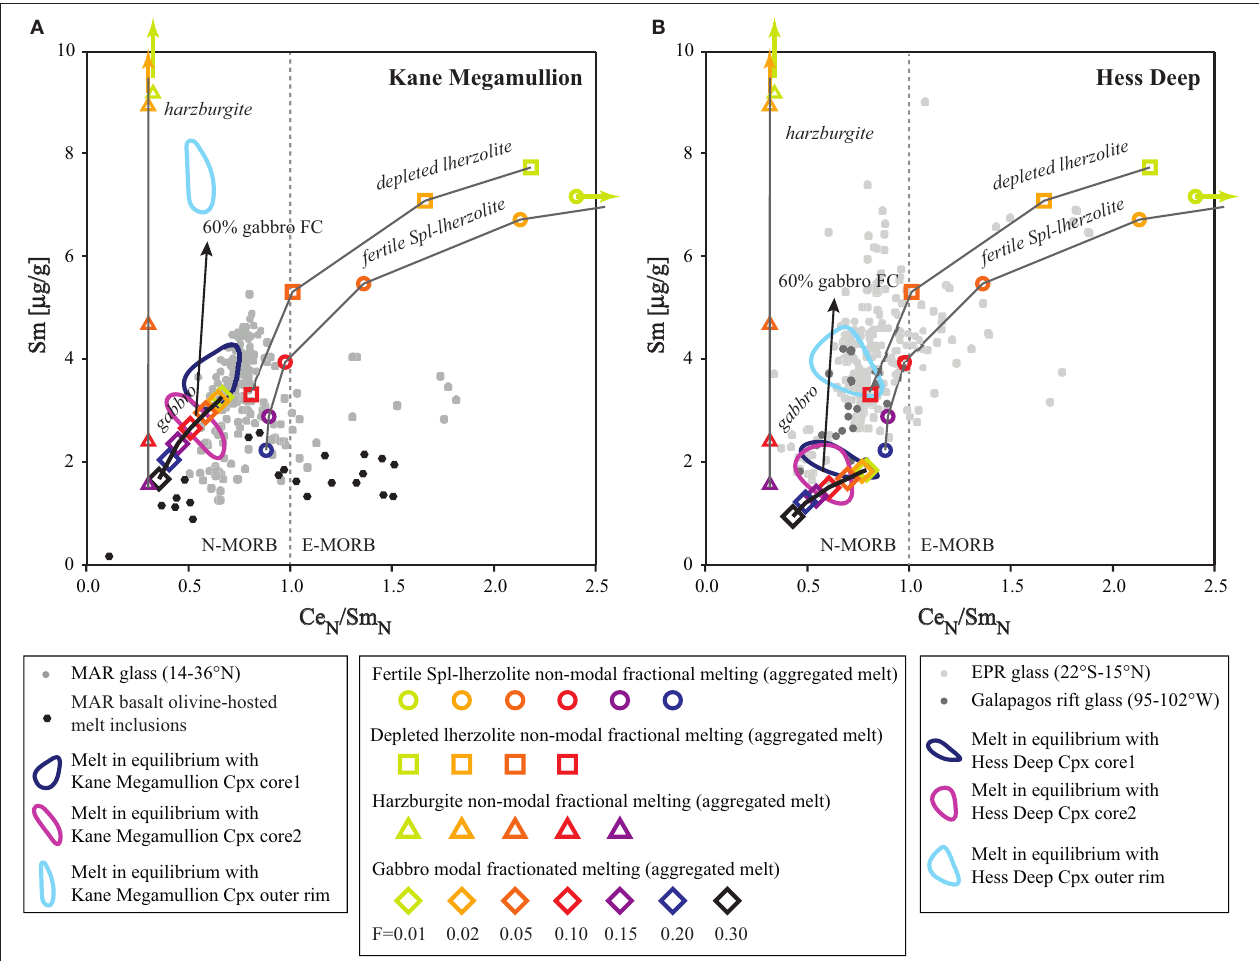
Figure 9 | Geochemistry of natural (A) Mid Atlantic Ridge (MAR) and (B) East Pacific Rise (EPR) and Galapagos rift glasses, sampled close to Kane Megamullion and Hess Deep [( Gale et al., 2013), and PetDB, (Lehnert et al., 2000) databases]. Mid-Atlantic Ridge basalt (36 ◦ N, 9 ◦ N) high-Mg olivine-hosted melt inclusions are shown for comparison (some of which contain too much clinopyroxene components) ( Sobolev and Shimizu, 1993; Shimizu, 1998). The Kane Megamullion and Hess Deep clinopyroxene core1 are in chemical equilibrium with the basaltic glass having low Sm concentration and low Ce/Sm ratio. Such compositions can be reproduced by depleted spinel-lherzolite to harzburgite partial melting (liquid fraction F ≈ 0.05–0.15) (starting compositions by Jochum et al., 1989) (modal and non-modal and also equilibrium and Rayleigh fractional melting with aggregated melts give very similar results). The melt chemistry in equilibrium with the clinopyroxene core2 is Sm-depleted and has low Ce/Sm in comparison to core1. In combination with resorption textures ( Figure 2 ) and complex zoning ( Figures 3 , 4 ), it seems likely that hybridization of lherzolite-derived melt ( F = 10–20%) with gabbro partial melts ( F = 10–30%) in variable proportions occurred. The MOR melt samples with such chemical characteristics may have been overprinted by gabbro assimilation during transport through and storage in the lower oceanic crust. Upon gabbro fractional crystallization (FC), the melt Sm concentration increases at nearly constant Ce/Sm ratio. See Table A.4 for geochemical modeling of partial